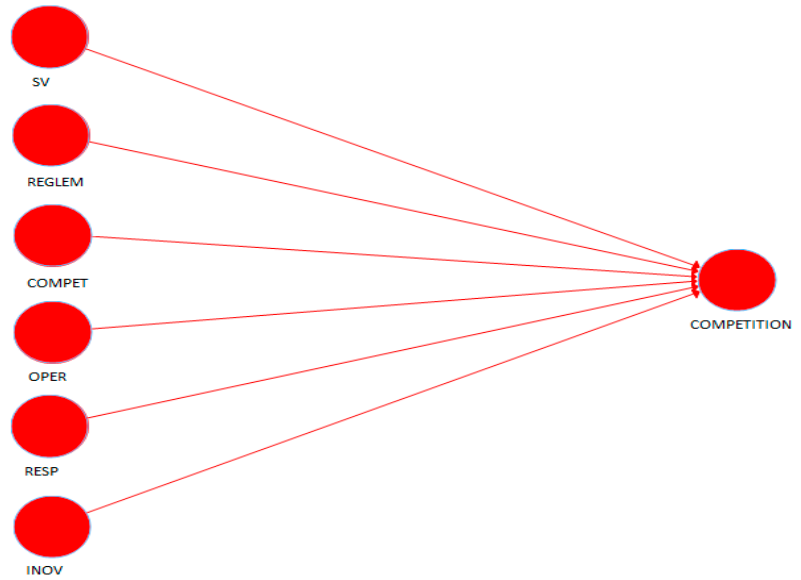
Figure 2. Structural model that incorporates the results of rational behavior in modeling the impact of green procurement on competition.